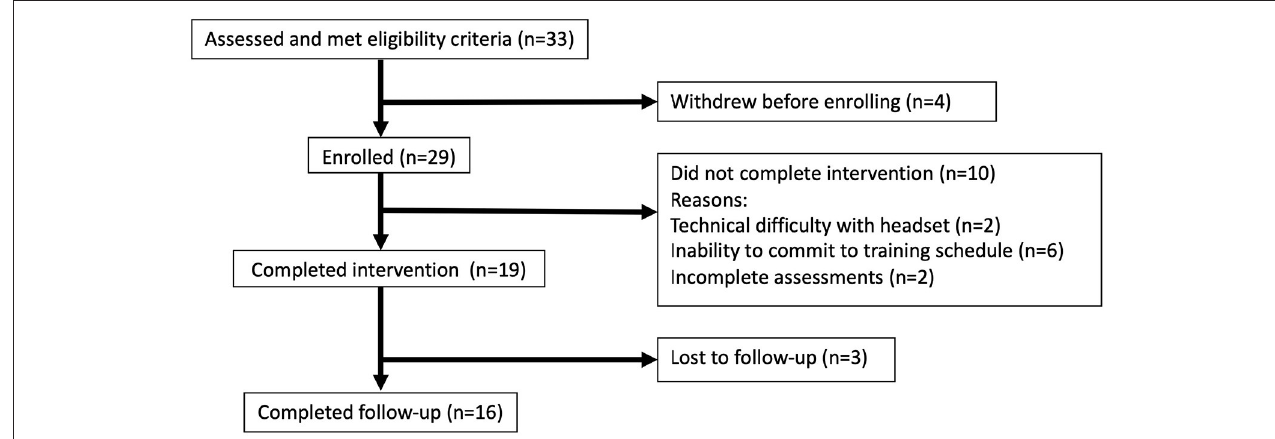
FIGURE 2 | Participant consort diagram showing the process of selection, training and follow-up.